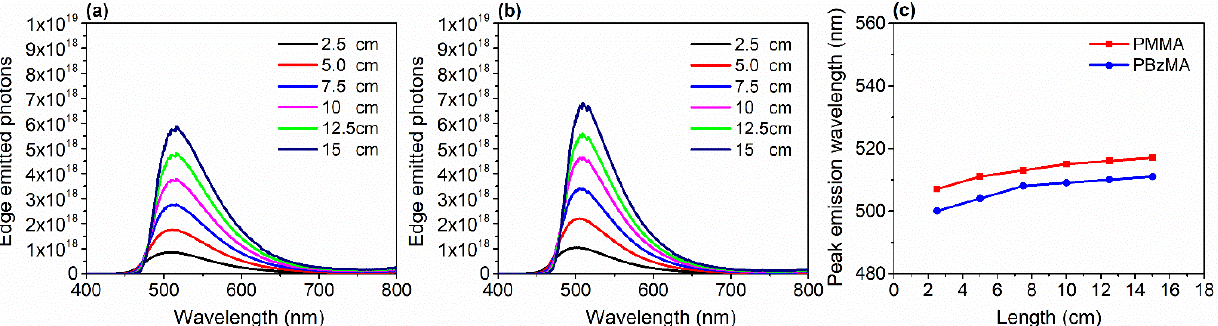
Figure 4. (a) Edge emitted photons spectra of DACT-II/PMMA-film LSCs at various lengths. ( b ) Edge emitted photons spectra of DACT-II/PBzMA-film LSCs at various lengths. ( c ) Peak emission wavelengths of LSCs with different lengths. All the LSCs were square-shaped so that length = width .